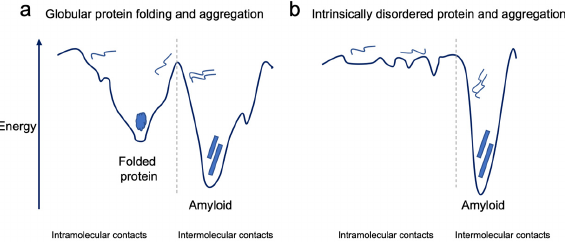
Figure 1. Schematic energy landscapes of globular proteins ( a ) and IDPs ( b ). Both energy landscapes are split into two halves illustrating intramolecular contacts and intermolecular contacts. ( a ) The globular folded protein is the conformation with the lowest energy based on intramolecular con- tacts. However, aggregation can result in conformations that are even lower in energy, illustrating that amyloid fibril formation is thermodynamically more favorable than the native state. ( b ) IDPs exist in an ensemble of conformations that may have transient intra- and intermolecular contacts. Intermolecular contacts leading to aggregation of IDPs can result in highly stable amyloid aggre- gates.